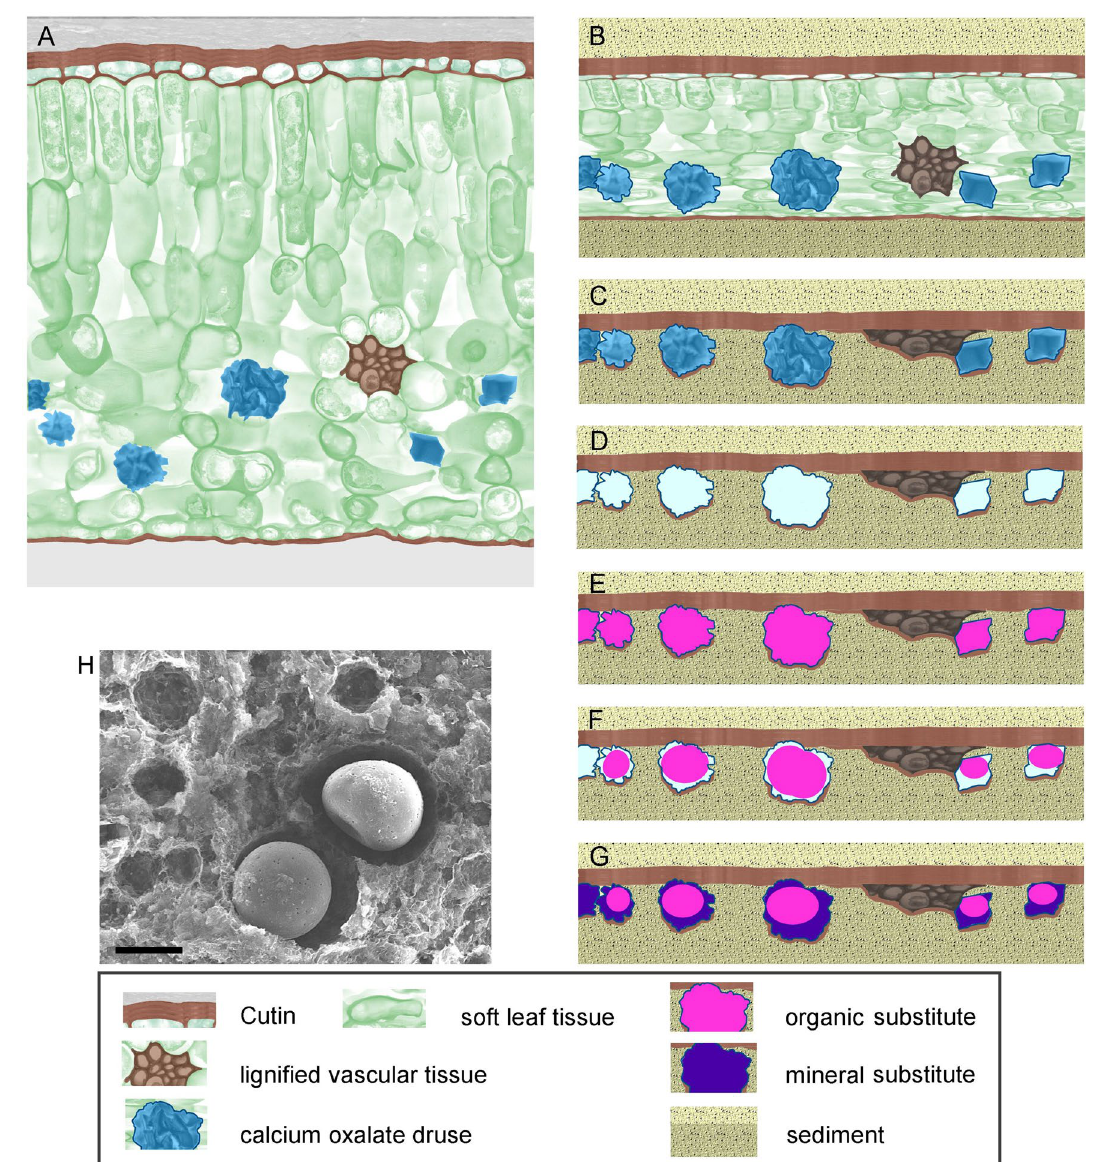
Figure 6. Model of the fossilization processes that lead to the formation of globular and serrate replications of CaOx crystals and druses. ( A ) Distribution of CaOx and other structures in a fresh leaf. ( B – G ) Fossilization steps. ( B ) Covering with sediment; compression, loss of water; ( C ) Decomposition of soft organic tissue material; ( D ) Dissolution of CaOx forms voids; ( E ) Voids are filled with organic matter, perhaps cutin components; ( F , G ) partial shrinkage of organic material forms globules due to surface tension; new voids formed by shrinkage are filled with ghost mineral components. ( H ) SEM image of a freshly cleaved plane of leaf coal sample Ro-59.9 (see Fig. 3g–h). Larger cavities contain shrunken remnants of organic material, whereas smaller cavities are empty. Scale bar = 20 the elements Si, Al, Fe, S, and sulphate ions 4 . Anaerobic conditions, indicated by the presence of pyrite, may have inhibited the oxidation of calcium oxalate to carbonate, thereby facilitating preservation. The presence of calcium oxalate druses or crystals and their distribution patterns as well as their fossil traces may be utilized as additional useful micromorphological features for the identification of fossil plant taxa in the future, if more records are available and if these records can be unambiguously related to extant taxa. Pattern, shapes and sizes of CaOx traces could be particularly helpful if leaf cuticles are not preserved. Angiosperms show a great variability of biomineralization patterns including CaOx, particularly dicotyledons contain almost all forms of CaOx druses and crystals. Some families of monocotyledons (e.g., Araceae, Arecaceae) contain CaOx raphide bundles, others such as Poaceae (grasses) are usually mineralized with silica but not with CaOx. In Gymnosperms, CaOx occurs in different forms: Conifers usually contain small crystals (< 10 µm) on the surfaces